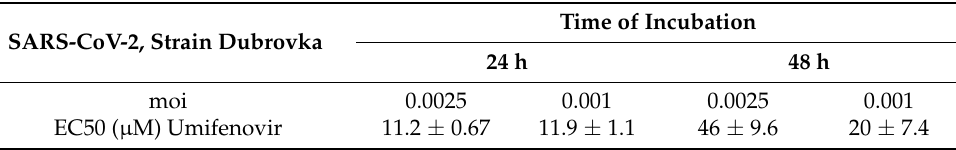
Table 1. Antiviral activity of umifenovir against SARS-CoV-2, strain Dubrovka in cell-ELISA assay. Graphical data present in Supplementary Materials (Figure